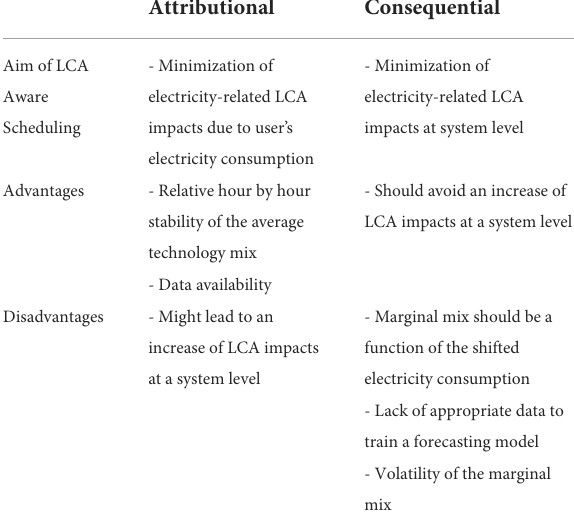
TABLE 1 Differences between an attributional and a consequential approach for the